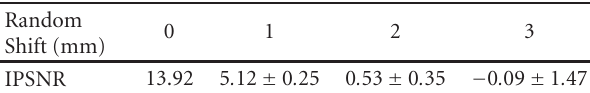
Table 4: Average IPSNR values of the proposed referred to B-Spline method in function of